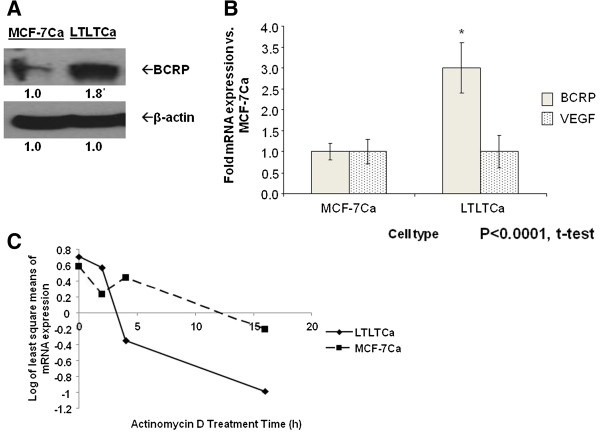
Comparison of BCRP protein and mRNA expression and stability in LTLTCa and MCF-7Ca cells. LTLTCa and parental MCF-7Ca cells were plated and cultured in their respective passage media under normal cell culture (nonhypoxic) conditions. A) Total protein was extracted and BCRP and β-actin were analyzed by Western blot analysis. Densitometry results are expressed as fold-change in protein levels compared to MCF-7Ca cells after normalization to β-actin (mean ± SD, n = 6 independent cell samples/group; *versus MCF-7Ca, P <0.0001, two-sided t test). B) Total RNA was extracted and BCRP mRNA, VEGF mRNA and 18S rRNA were analyzed by real-time RT-PCR analysis. Results are expressed as the fold-change in mRNA levels compared with MCF-7Ca cells after normalization to 18S rRNA (mean ± SD, n = 6 independent cell samples/group; *versus MCF-7Ca, P <0.0001, two-tailed t-test). C) LTLTCa and MCF-7Ca cells were treated with vehicle or 0.5 μg/ml actinomycin D for 0 to 16 hours. Total RNA was extracted and BCRP mRNA was analyzed by real-time RT-PCR. Results are expressed as least square means of log transformed averages of mRNA expression at various timepoints (trend over time) after normalization to corresponding vehicle-treated samples, and analysis by linear mixed effect model adjusting for experiment, cell line, and cell line*time interaction (mean ± SD of n = 6 independent cell samples/group; *versus MCF-7Ca; effect of gene type P = 0.0025, effect of cell type P = .3749, interaction between gene type and cell type P = 0.0025; two-way ANOVA). ANOVA, analysis of variance; BCRP, breast cancer resistant protein; n, number; SD, standard deviation; VEGF, vascular endothelial growth factor.